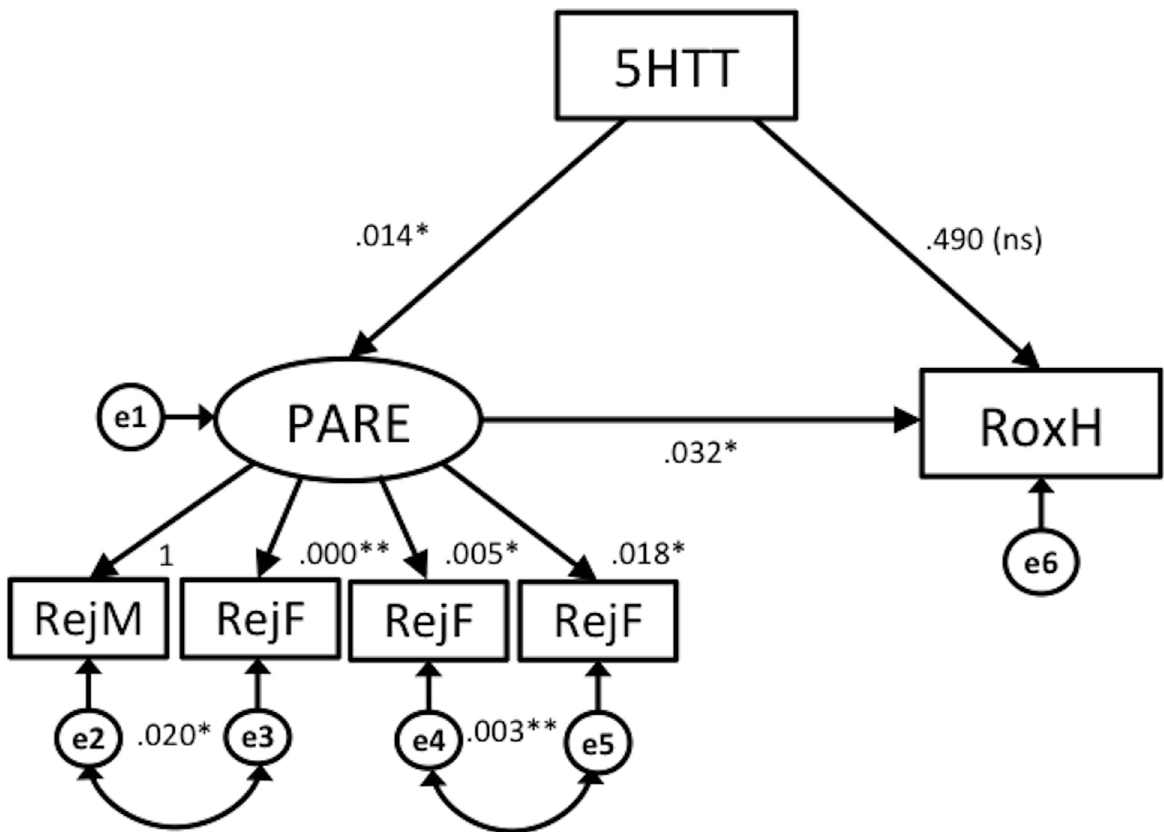
Fig 6. Structural Equation Model 1. Note: All paths significant ( ** p < .001 * p < .05) unless indicated (ns). 5HTT = 5-HTTLPR, PARE = Perceived parenting style (ReF = Paternal Rejection, ReM = Maternal Rejection, EmF = Emotional warmth from father, EmM = Emotional warmth from mother), RoxH = Right frontal oxygen hemoglobin.